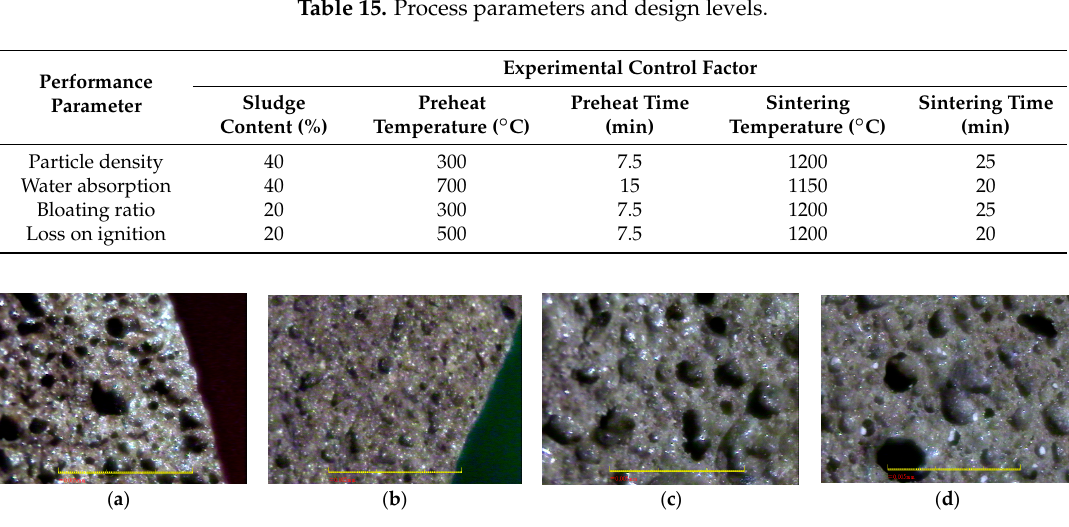
Figure 7. The internal cellular pore system of the sintered LWA. ( a ) experiment number F4; ( b ) experiment number F11; ( c ) experiment number F15; and ( d ) experiment number F16. Table 14. Particle density and water absorption of three main synthetic LWAs [2]. Table 16. Particle density and water absorption of various lightweight